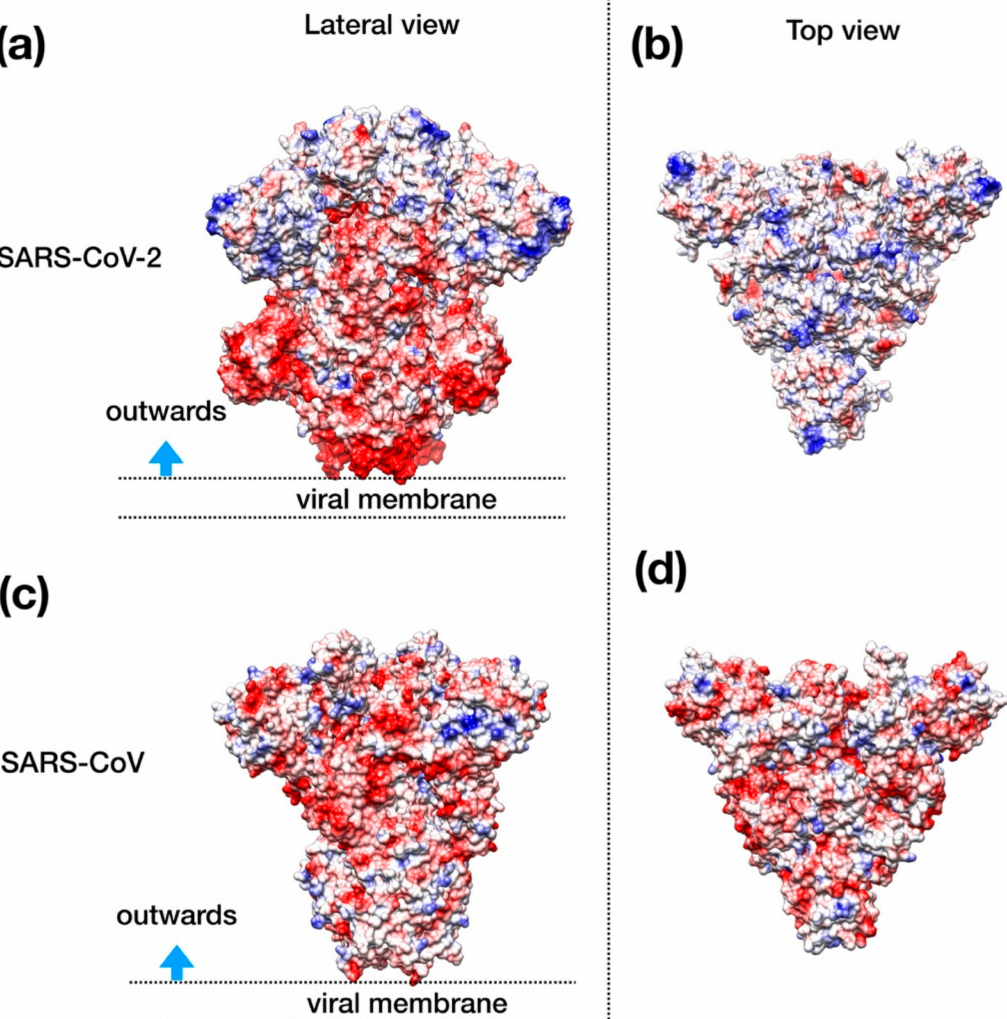
Figure 4. Structural representation of the spike trimer from SARS–CoV-2. ( a ) Molecular surface of the trimer structure, colored according to the local values of the electrostatic potential. The color palette ranges from − 10 kcal / (mol · e) (red) to + 10 kcal / (mol · e) (blue). ( b ) Top view of the same representation as in panel A. ( c ) Spike envelope protein from SARS-CoV. Same lateral view as in panel ( a ). ( d ) Top view of the same representation as in panel ( c